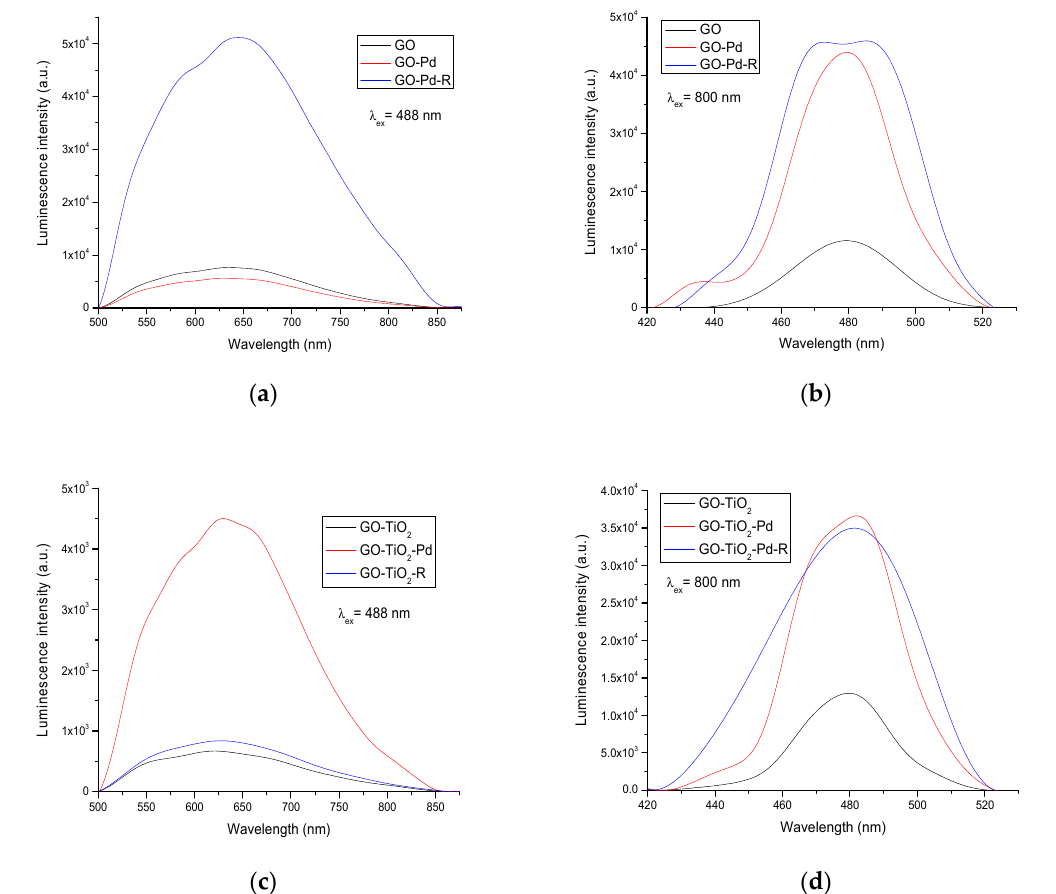
Figure 6. Emission spectra of Pd/GO ( a , b ) and Pd/GO-TiO 2 ( c , d ) at different excitation lines.